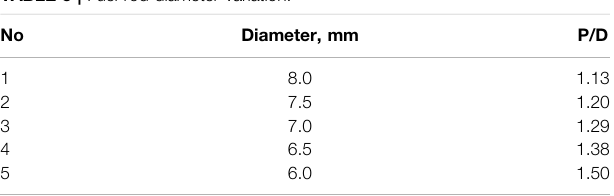
TABLE 5 | Fuel rod diameter variation.